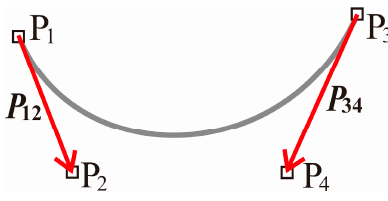
Figure 4. Definition of a Bezier curve.